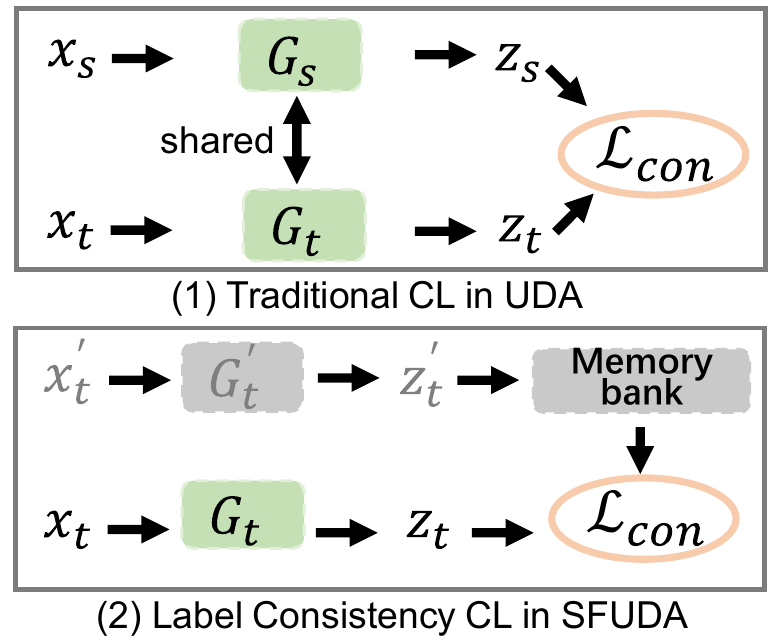
Figure 1. Our label consistency contrastive learning is different from the traditional contrastive learning in unsupervised domain adaptation.